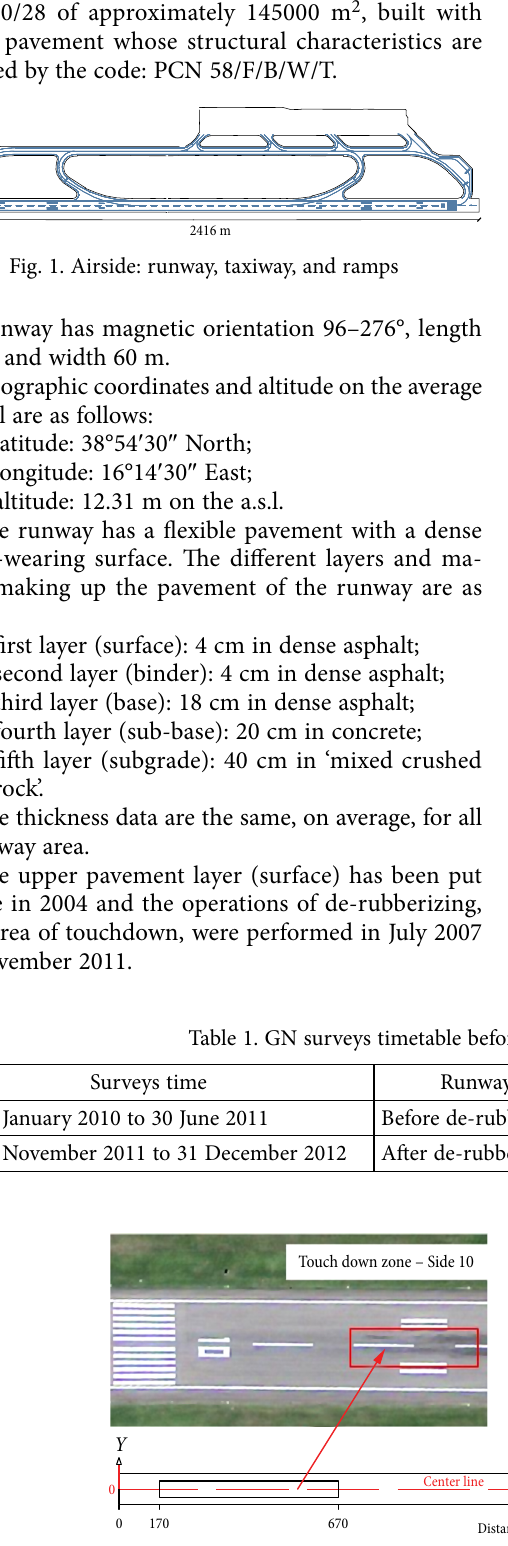
Fig. 4. Touchdown zones before de-rubberizing made in November